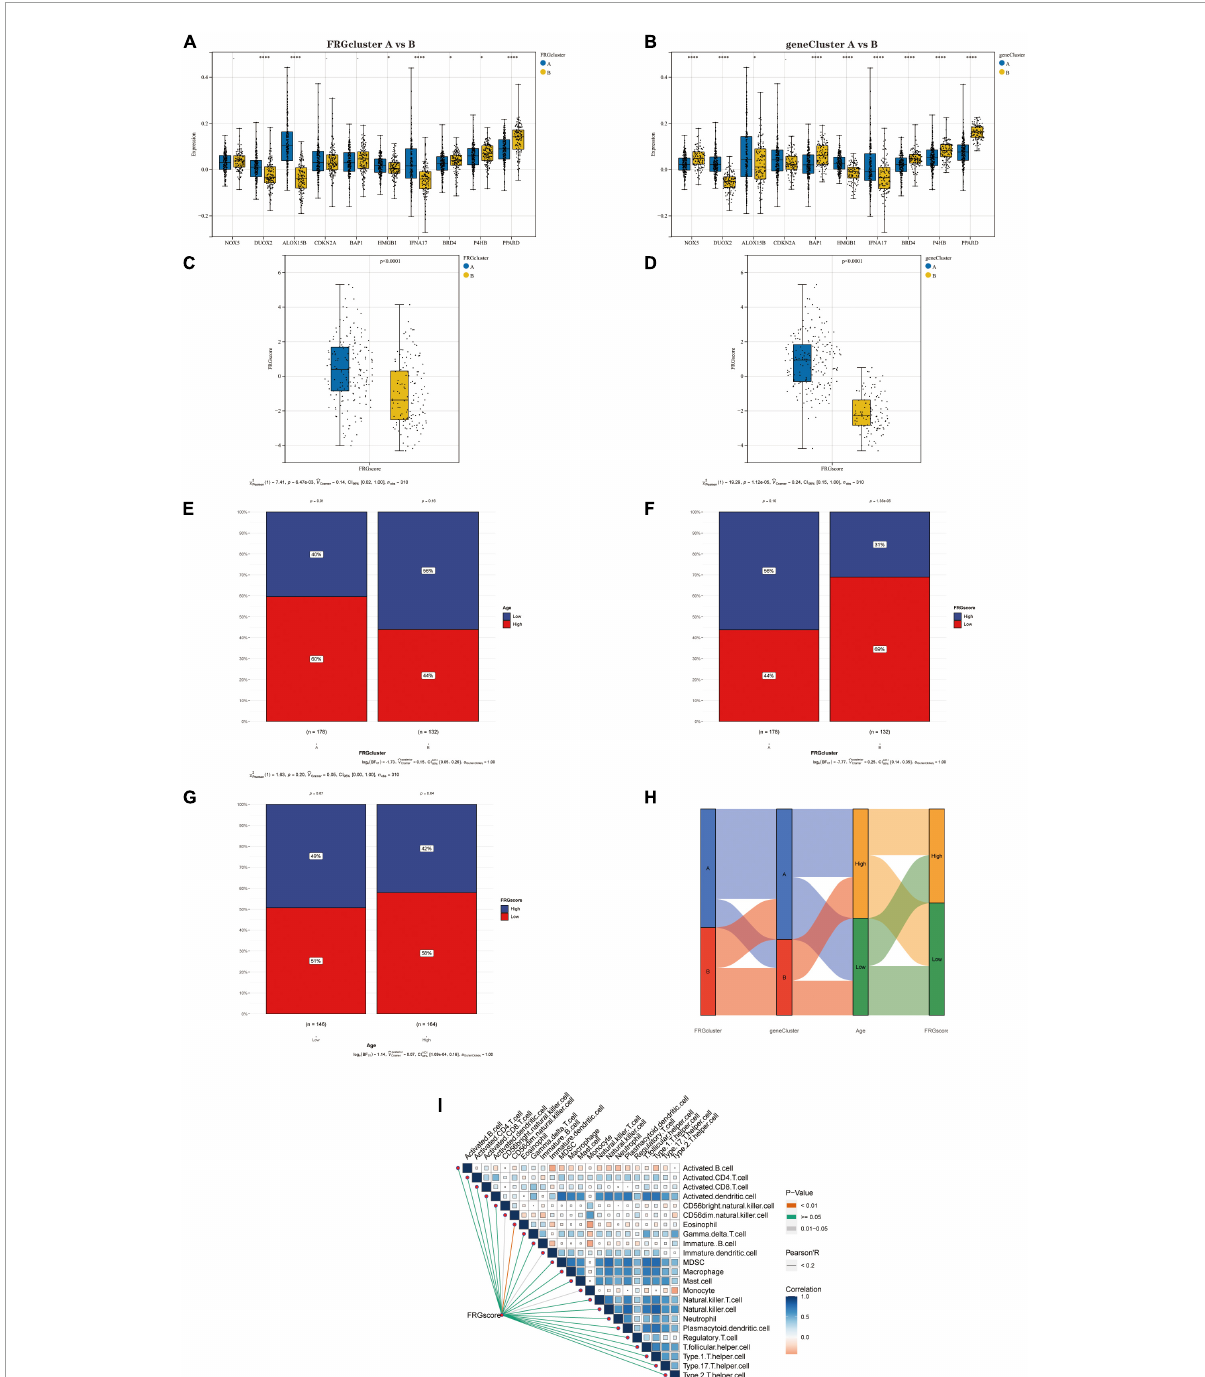
FIGURE7 (A) Differential expression of Hub genes between FRGcluster A and B. (B) Differential expression of Hub genes between geneCluster A and B. (C) The corresponding FRGscore was obtained based on the PCA algorithm to compare the similarities and differences between the FRGcluster A and B subtypes FRGscore values. (D) The corresponding FRGscore was obtained using the PCA algorithm to compare the similarities and differences between the geneCluster A and B subtypes FRGscore values. (E) Percentage of senior and junior populations in both FRGcluster A and B subtypes. (F) Percentage of high and low age groups in both FRGcluster A and B subtypes. (G) Age distribution of the population in the high FRGscore and low FRGscore groups. (H) Sanky plots indicate clinical and molecular correlations. (I) Correlations between FRGscore and 28 immune cells. In this figure, the red line represents P < 0.01, the grey line represents P = 0.01–0.05, and the green line represents P ≥ 0.05; the colour of the squares represents the correlation coefficient, with blue being a negative correlation and red a positive correlation. ∗ P < 0.05; ∗∗ P < 0.01; ∗∗∗∗ P < 0.001. FRGcluster, Ferroptosis-related gene cluster; FRGscore, Ferroptosis-related gene score; PCA, Principal component